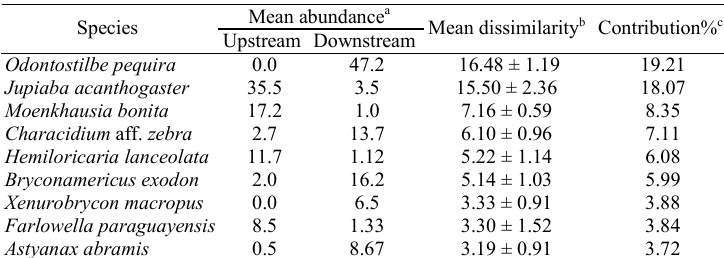
Table 4. Species contribution to dissimilarity between the upstream reaches (R1 and R2) and downstream reaches (R3, R4 and R5) of the Correntes stream, central west Brazil. a = Contribution of each species to the mean dissimilarity between groups. b = Mean dissimilarity between groups ± standard deviation. c = Contribution percentage of each species (> 3.0%) to the dissimilarity between